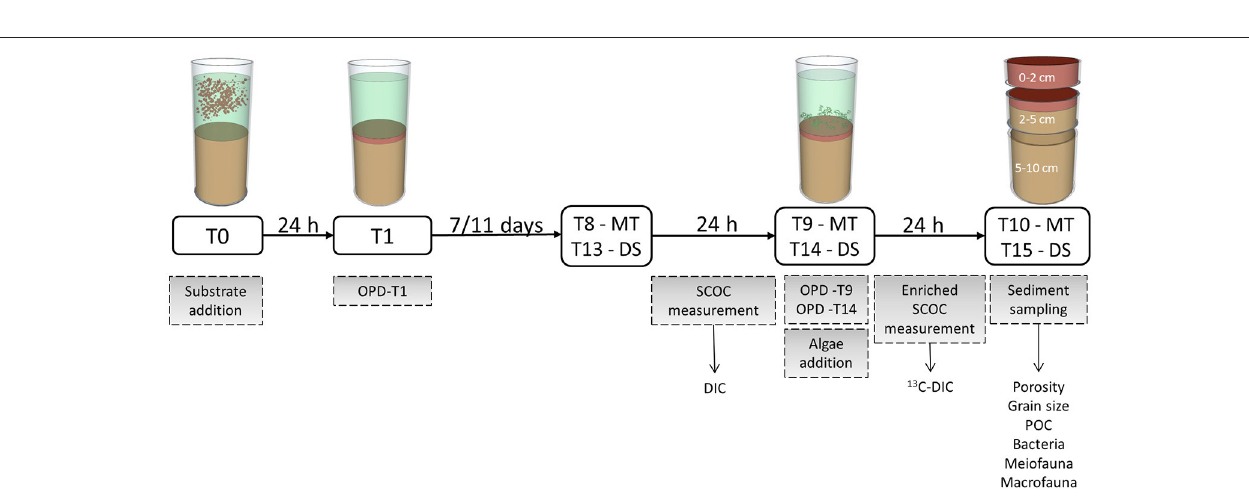
FIGURE 2 | Scheme of manipulations and samplings during the experiment. Treatments included the addition of mine tailings (MT) with 0.1, 0.5, and 3 cm thickness and the addition of dead sediment (DS) with 0.5 and 3 cm thickness. “T” Indicates the days of incubation after substrate addition. Actions and measurements are shown in gray boxes while arrows indicate from which measurements the different variables were obtained. Abbreviations: OPD, Oxygen penetration depth; SCOC, Sediment community oxygen consumption; DIC, Dissolved inorganic carbon; POC, Particulate organic